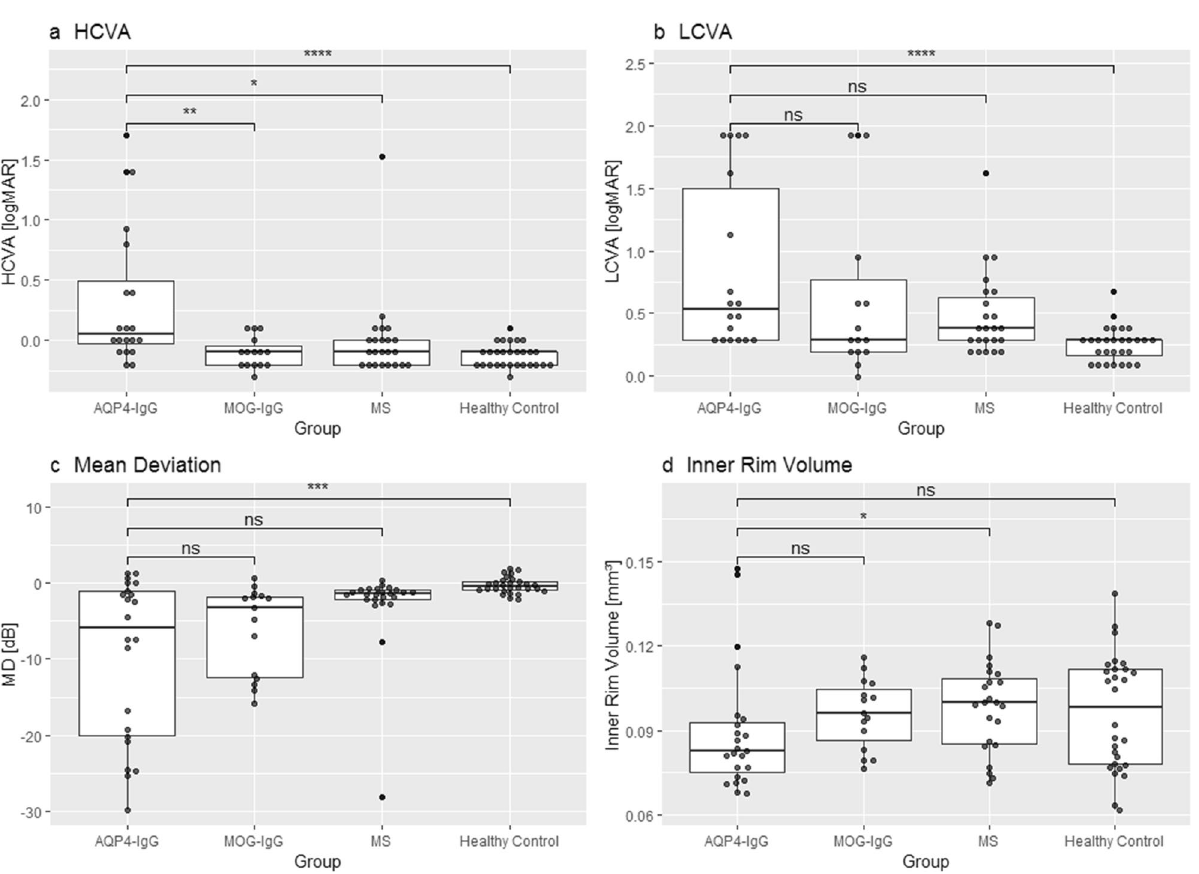
Figure 1. Group comparison of selected structural and functional parameters. ( a ) High contrast visual acuity ( b ) Low contrast visual acuity ( c ) mean deviation of visual fields and ( d ) inner rim volume of the fovea of eyes with history of ON AQP4-IgG: Aquaporin-4 IgG seropositive patients; MOG-IgG: Myelin-Oligodendrocyte- Glycoprotein seropositive patients; MS: Multiple Sclerosis; HCVA: High contrast visual acuity; LCVA: Low contrast visual acuity; logMAR: Logarithm of minimum angle of resolution; MD: mean deviation; p-values from Mann–Whitney-U Test (ns: p > 0.05; *: p < 0.05; **: p < 0.01; ***: p < 0.001; ****: p <